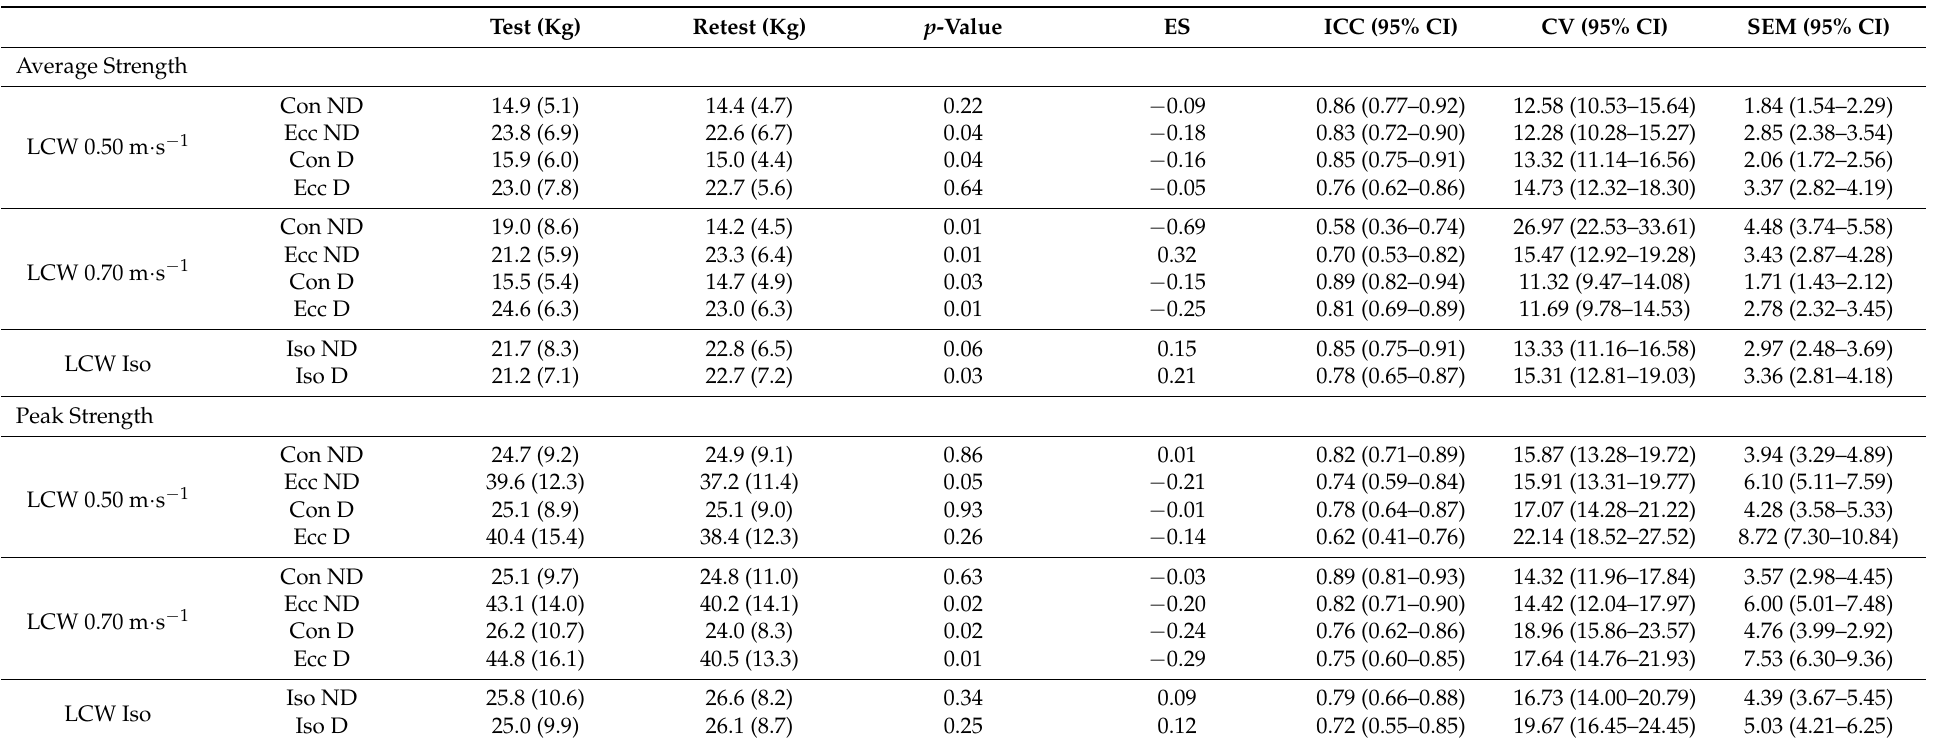
Table 1. Absolute and relative test-retest reliability of the average and peak strength low cable woodchop